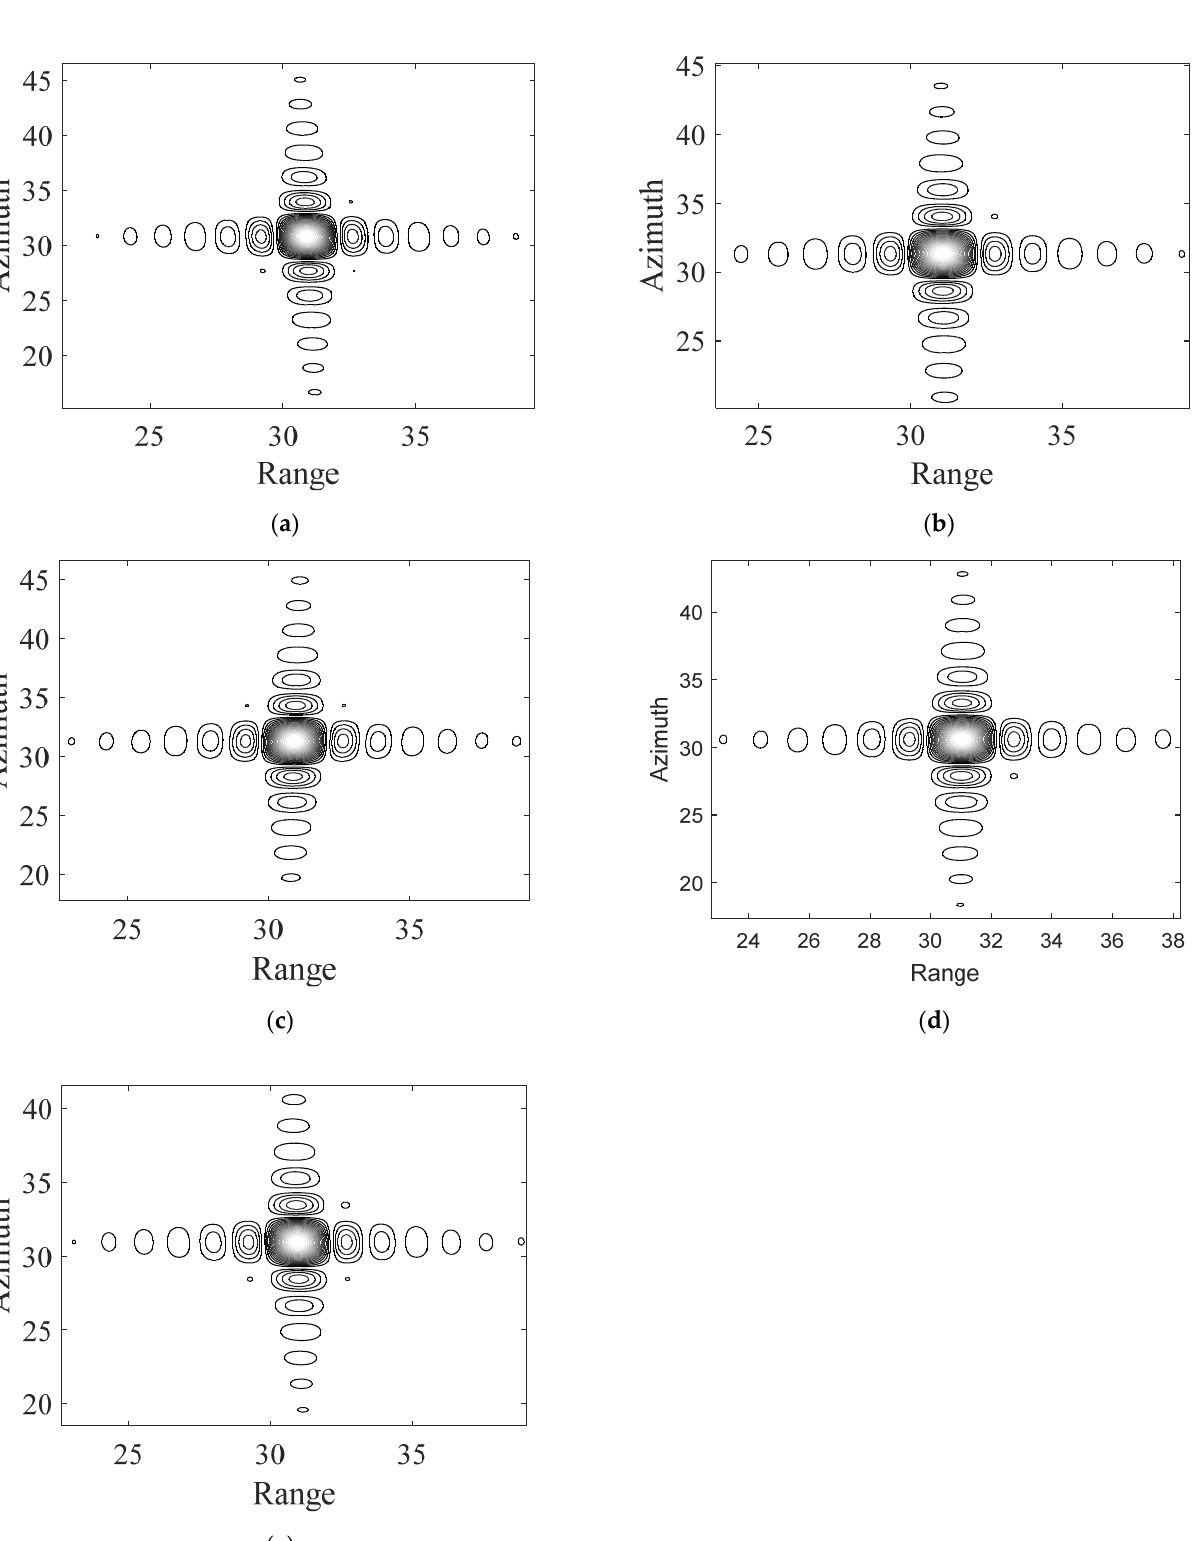
Figure 6. Solving processes of the optimization problem. ( a ) T1, ( b ) T2, ( c ) T3, ( d ) T4, and ( e ) T5.